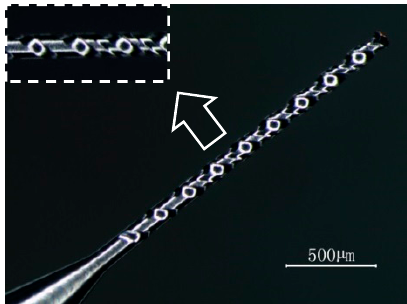
Figure 3. Structure of helical electrode.